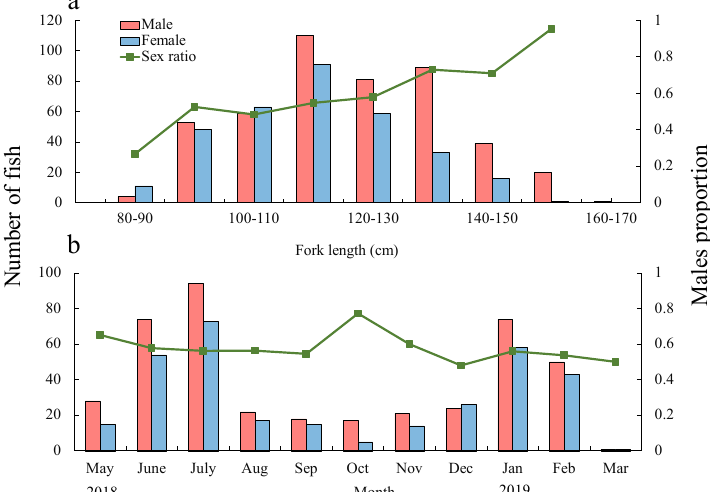
Figure 2. Fork length (FL) composition columns by sex ( a ) and month ( b ) and the proportion of males (line) in T. albacares .